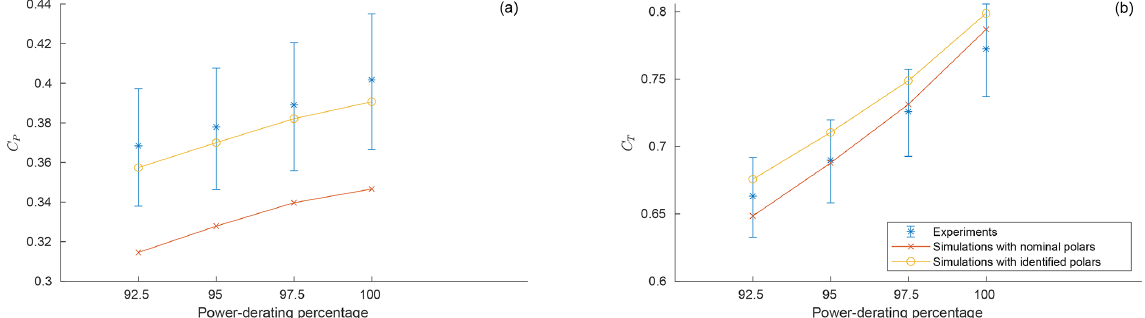
Figure 6. Results for the power-derating cases. (a) Power coefficient, (b) thrust coefficient. Solid blue line with ∗ symbols: experimental results, including uncertainties according to Table 1; solid orange line with ◦ symbols: simulation results with newly identified polars; solid red lines with × symbols: simulation results with nominal polars according to Bottasso et al.